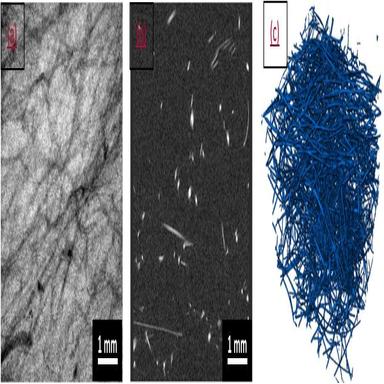
Glass wool sample: (left) X-ray projection (center) tomographic section after reconstruction (right) 3D rendering.